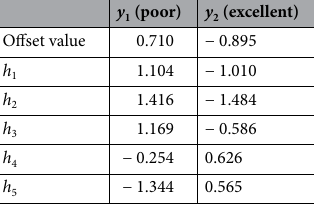
Table 4. Hidden layer to output layer connection weights and biases.